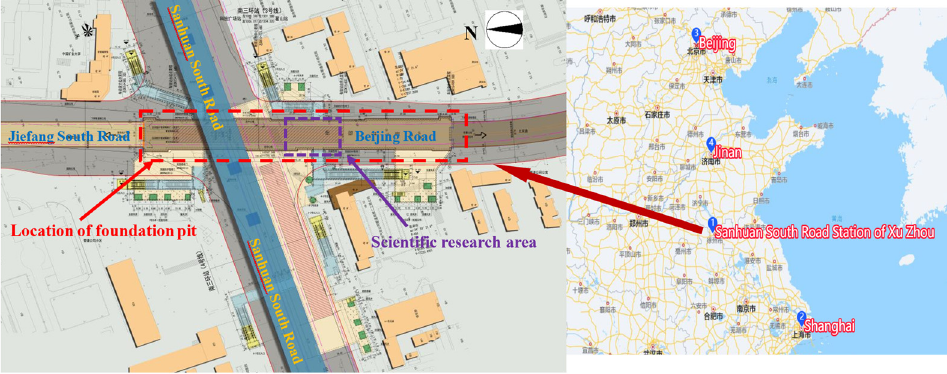
Figure 15. Location diagram of Sanhuan South Road Station.